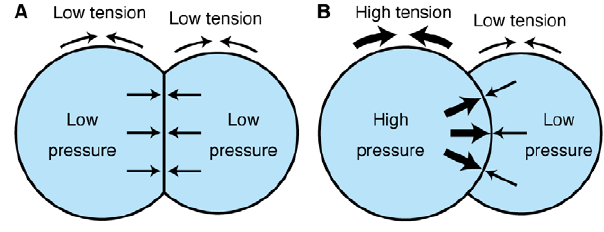
Figure 8. A model for the curved contact surfaces in the two- cell stage embryos. (A) Early two-cell stage. (B) Late two-cell stage.